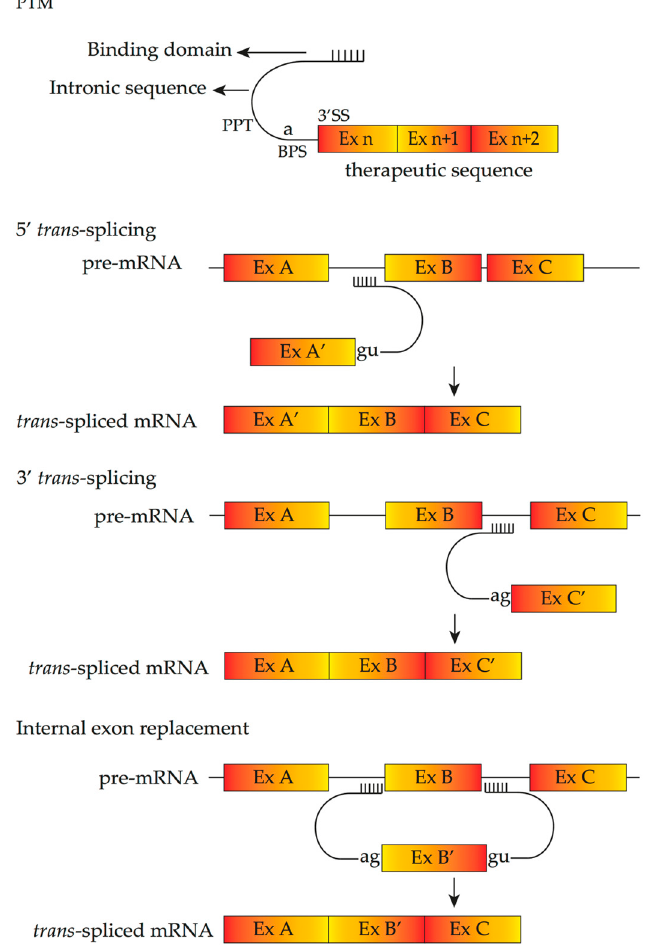
Figure 5. Schematic demonstrates pre- trans- splicing molecule (PTM) design and trans -splicing mechanism of three kinds of spliceosome-mediated RNA trans -splicing (SMaRT). The PTM includes a binding domain, an intronic sequence containing the polypyrimidine tract (PPT), the branch point sequence (BPS), the splice acceptor site (SS), and the therapeutic sequence. PTMs can be designed to replace 5’-exons, 3’-exons or internal exons [97]. The binding domain recognizes the target intron on endogeneous pre-mRNA by base pairing, thus, for 5 ′ - trans -splicing , resulting in a trans-spliced mRNA in which 5’ exons are replaced with the therapeutic sequence and for 3 ′ - trans -splicing , resulting in a trans-spliced mRNA in which 3’ exons are replaced with the therapeutic sequence. For internal exon replacement , binding domains are included at both ends of the PTM, resulting in a trans-spliced mRNA in which targeted internal exons are replaced with the therapeutic sequence.